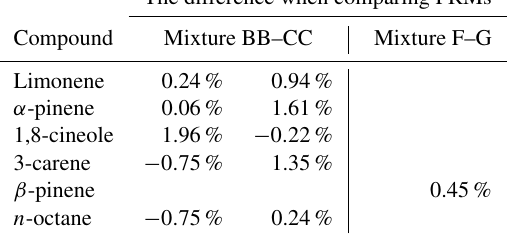
Table 2. Comparison showing the percentage difference between PRM mixtures prepared more than 2 years apart to assess the long- term stability of mixture BB and mixture F. Gravimetric values were normalised and the peak areas compared. There are two columns for the comparison of mixture BB and CC as the comparison was repeated on 2 consecutive days.